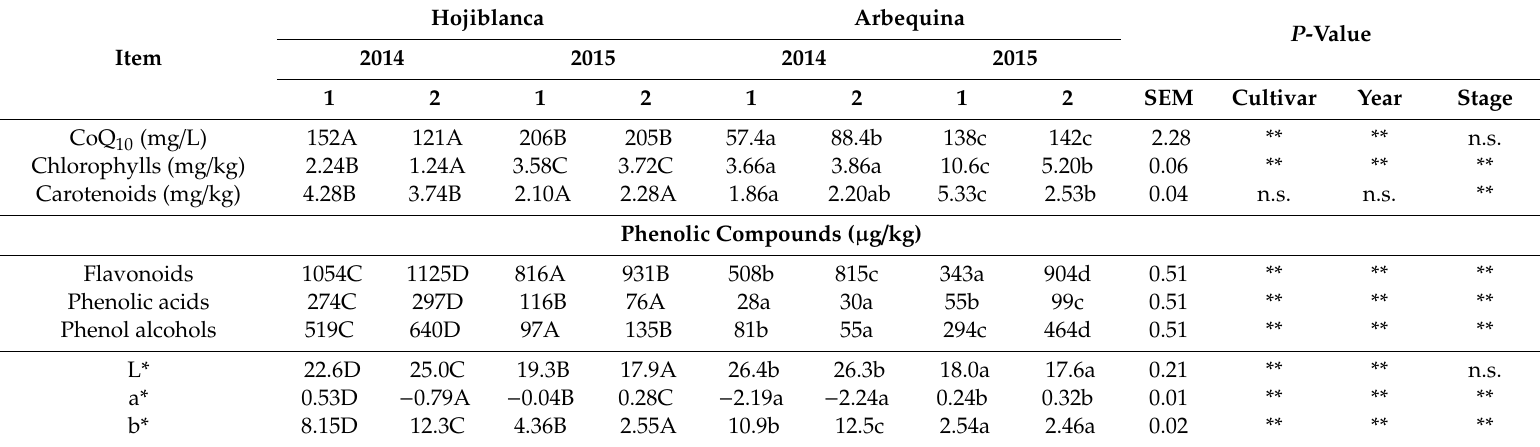
Table 2. Chemical compounds content (coenzyme Q 10 (CoQ 10 ), pigments and phenolic compounds) a and colour in